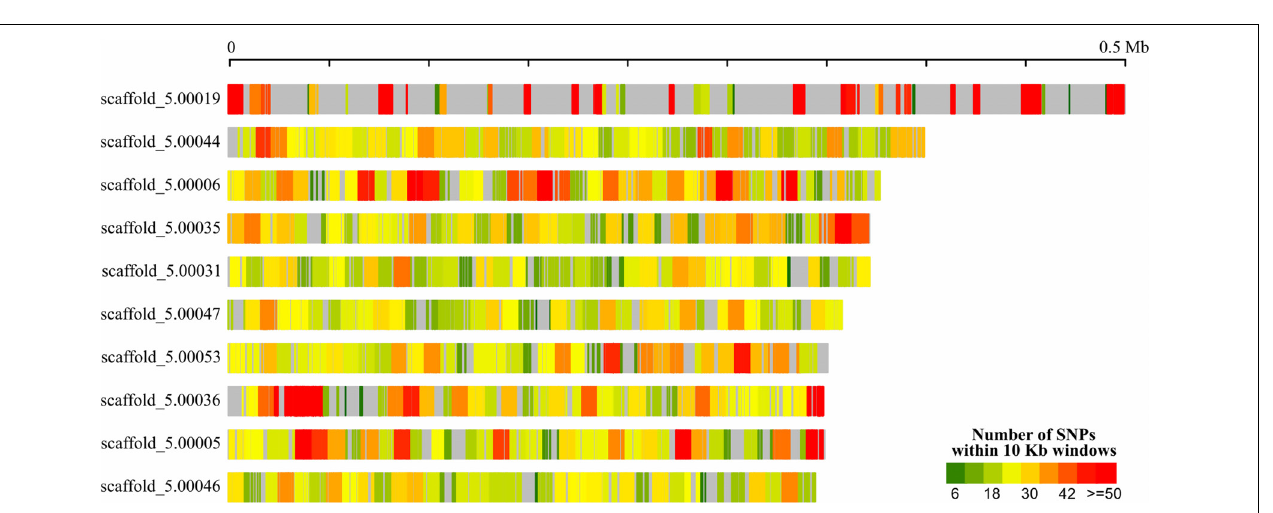
FIGURE 2 | Distribution of SNPs in 10 Kb windows across the 10 largest Ustilago hordei (barley) scaffolds. Repeat-masked genomes were used in NUCmer alignment. Repeat-masked or SNP-poor regions are shown in